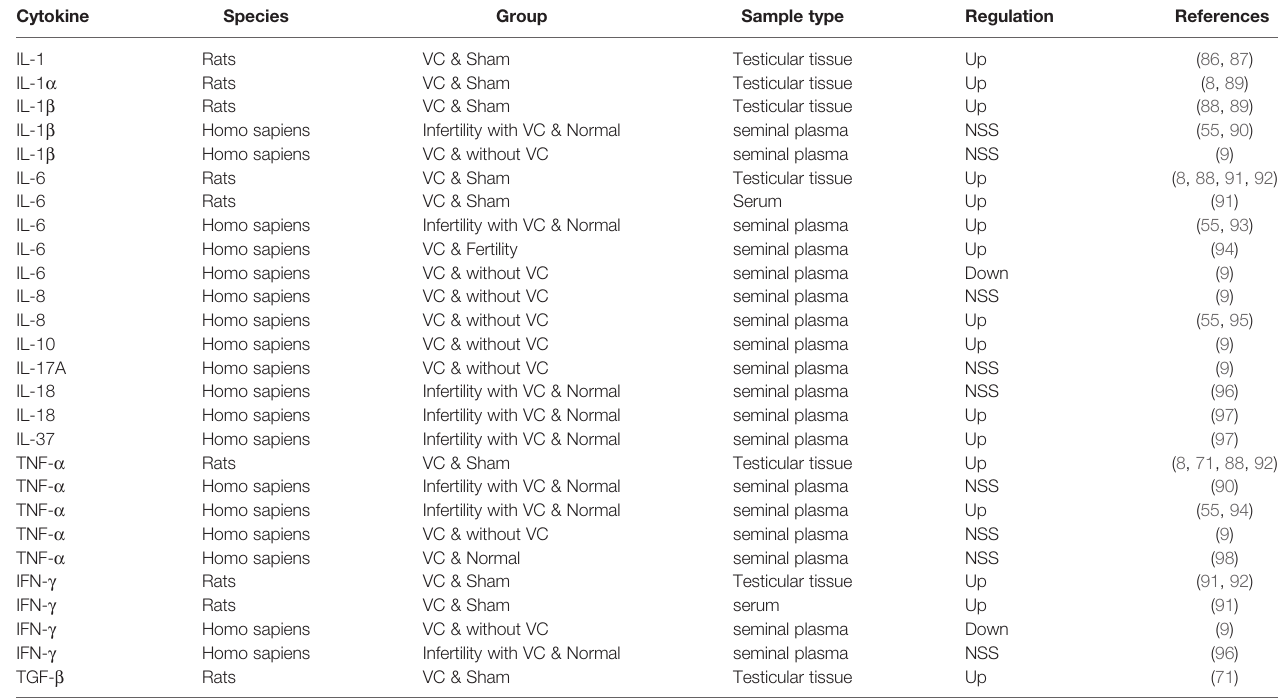
TABLE 1 | Summary of cytokine reported in VC of human and animal model.